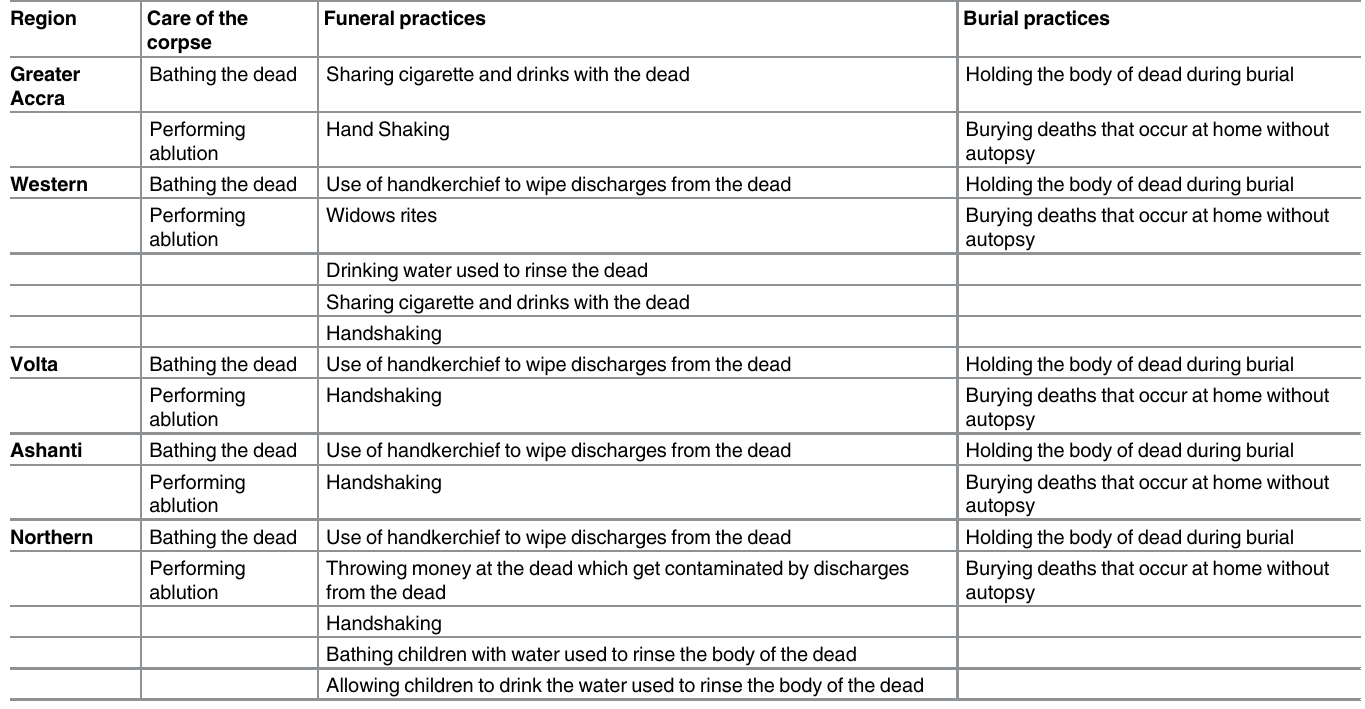
Table 1. High-risk funeral and burial practices in